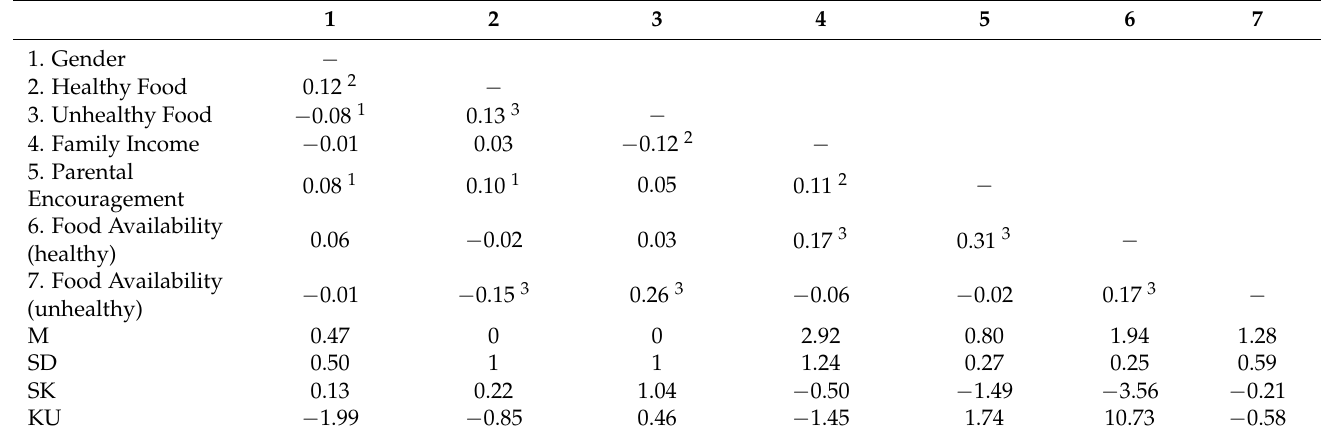
Table 1. Descriptive statistics and Pearson’s correlation